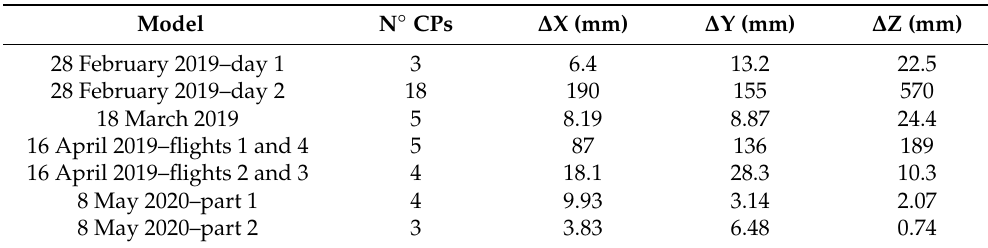
Table 3. CPs count and residual errors.